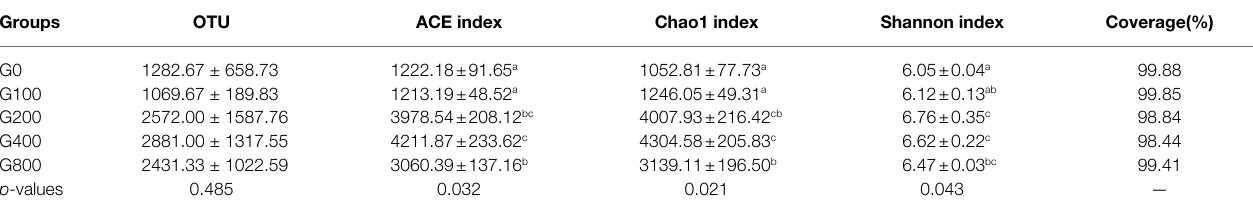
TABLE 7 | Effects of dietary GSH on alpha diversity index of intestinal microbiota in O. mykiss (mean ± SD, n = 3). Groups